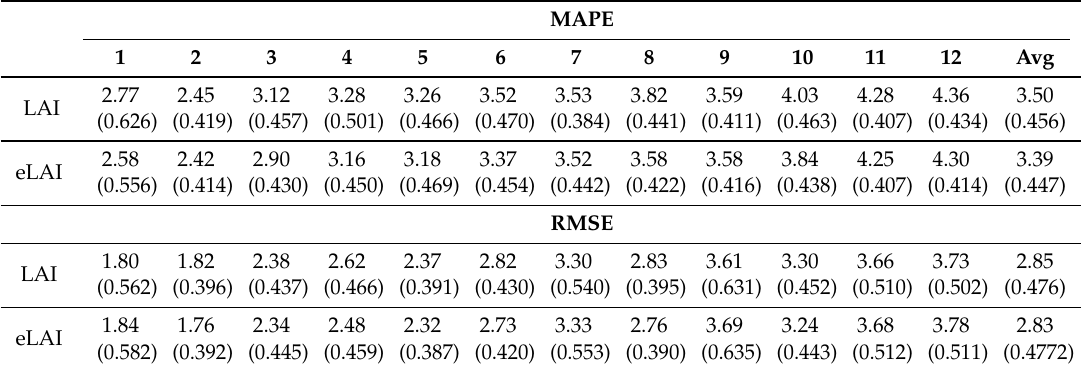
Table 3. Specific MAPE (%) and RMSE with no information on the variation (numbers in parentheses are upper bounds of a 95% confidence